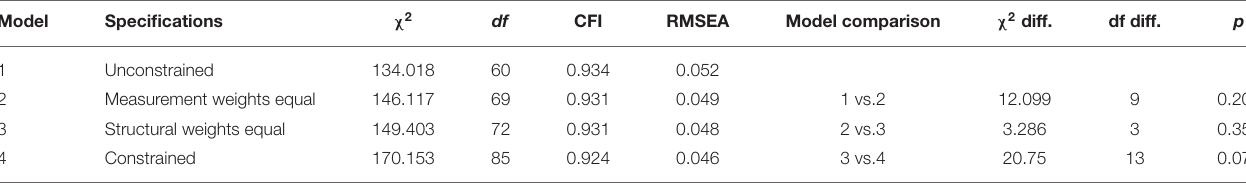
TABLE 4 | Results of multi-group analysis: boys vs. girls.